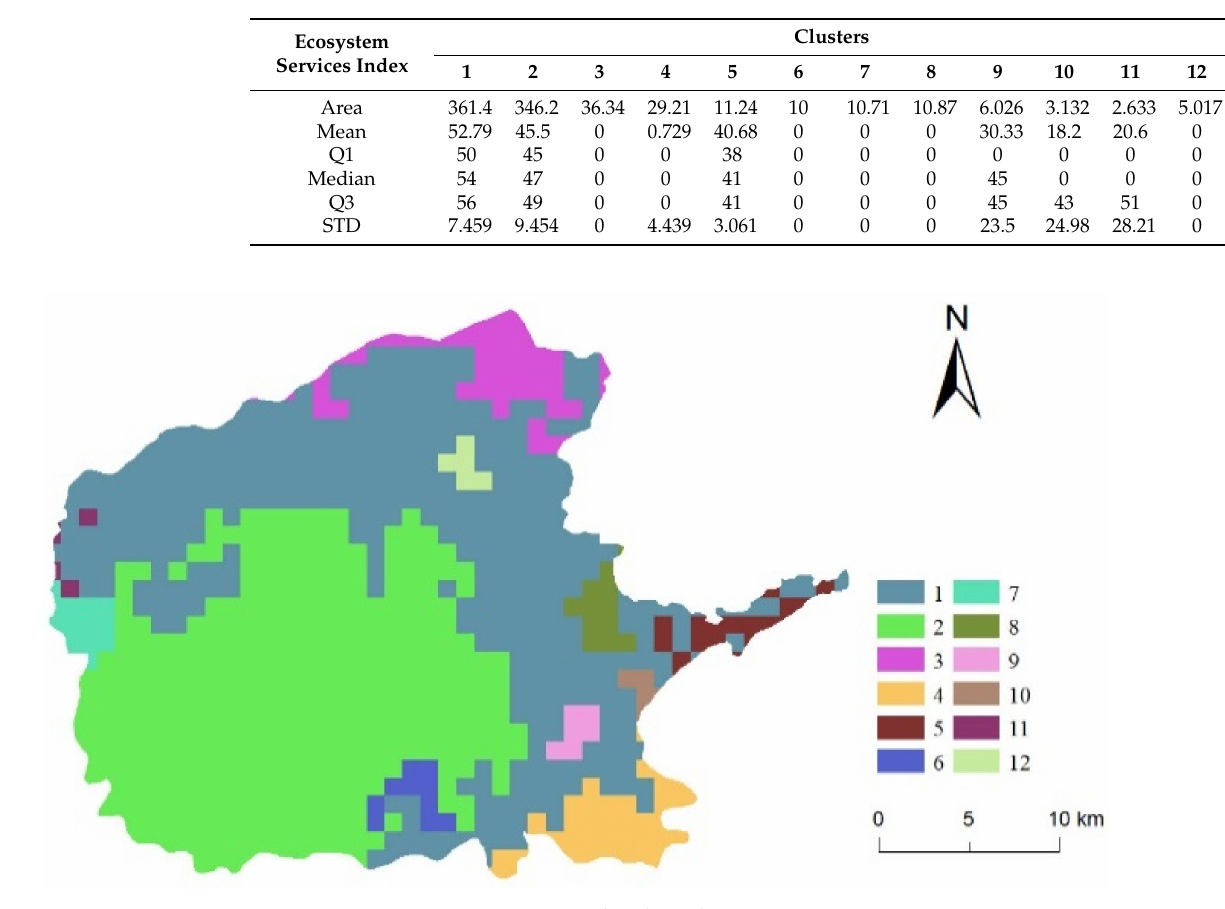
Figure 9. Regionalized results.